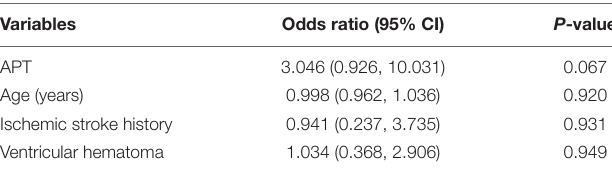
TABLE 3 | The effects of preoperative APT on postoperative rehemorrhage after adjustment.